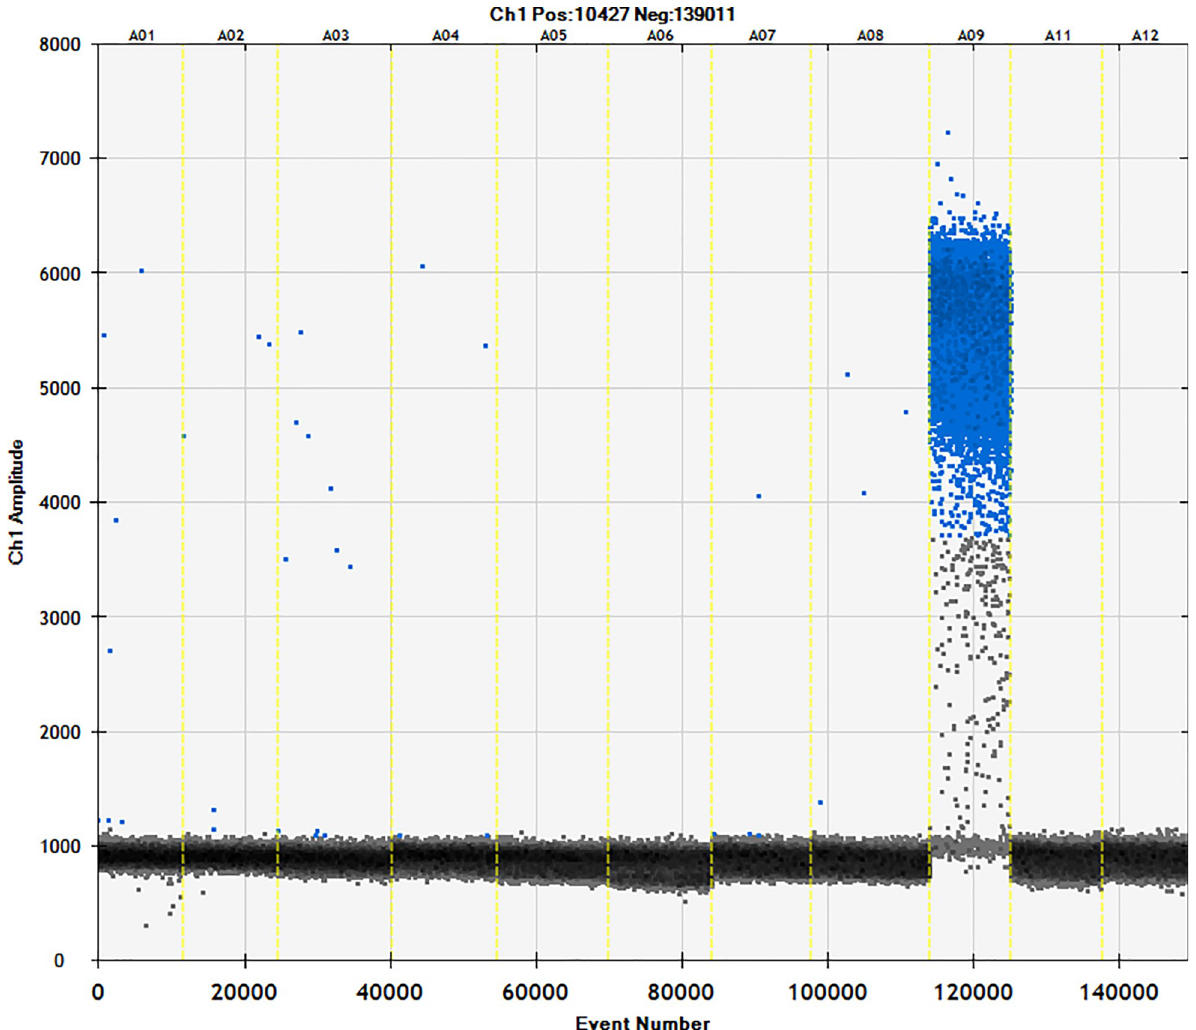
Fig 1. Validation of the specificity of cassava primers. The specificity of cassava primers were tested using the following samples: 1, beef; 2, lamb; 3, hazelnut; 4, soybean; 5, walnut; 6, sesame; 7, corn starch; 8, potato starch; 9, cassava starch; 10, sweet potato starch; and 11, ddH 2